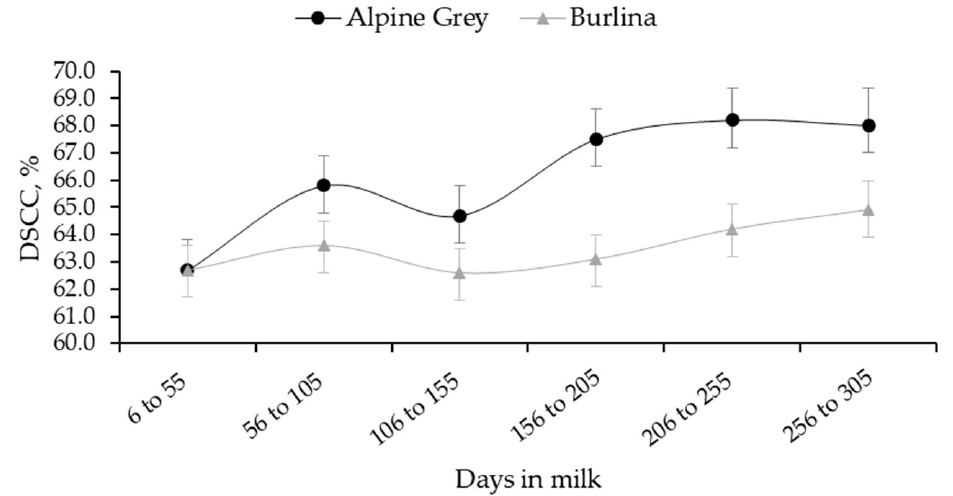
Figure 3. Least squares means of DSCC (combined proportion (%) of polymorphonuclear neutrophils and lymphocytes out of the total somatic cell count (cells/mL)) for the interaction between lactation stage and breed.